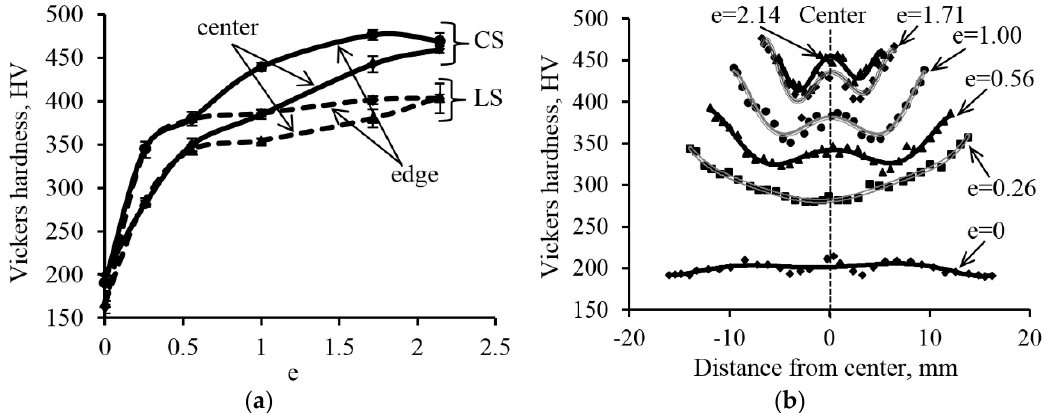
Figure 5. The results of the Vickers hardness study of the 321 MASS after various degrees of deformation: ( a ) The dependence of the center and the edge hardness in the cross section (CS–cross section) and the longitudinal section of the rod (LS—longitudinal section); ( b ) The hardness distribution over the cross section of the rod after deformation with different degrees.